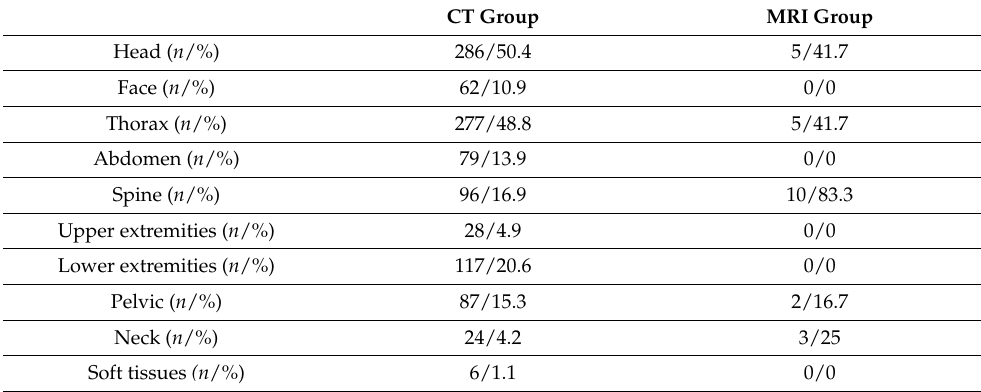
Table 3. Injuries in the respective body area with AIS ≥ 3 in the course of polytrauma injury with ISS ≥ 16.